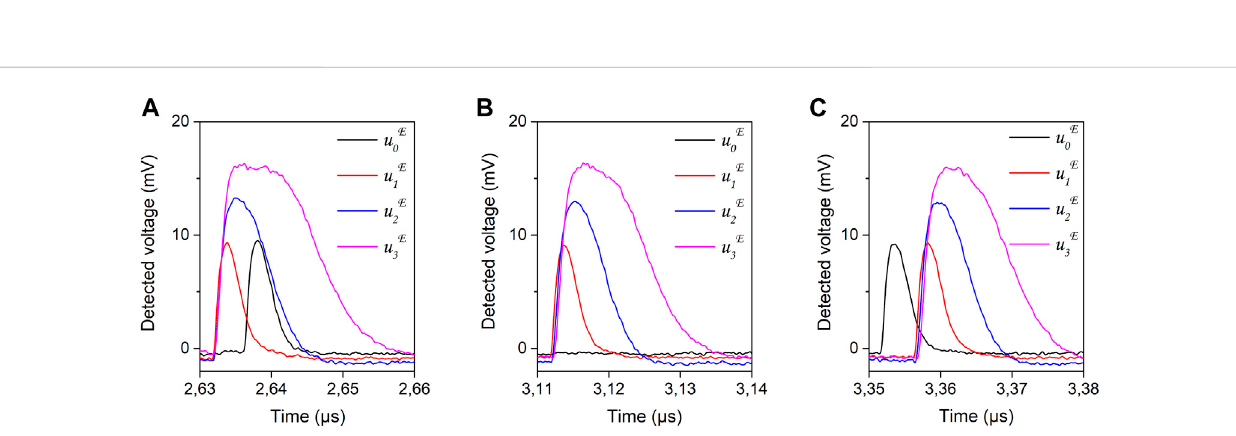
FIGURE 9 Detail of Figure 8, focusing on the three different timing conditions of the reference fi ltered signal u E 0 (black line). In (A) u E 0 fi res after the stimuli fi lteredinputs ( u